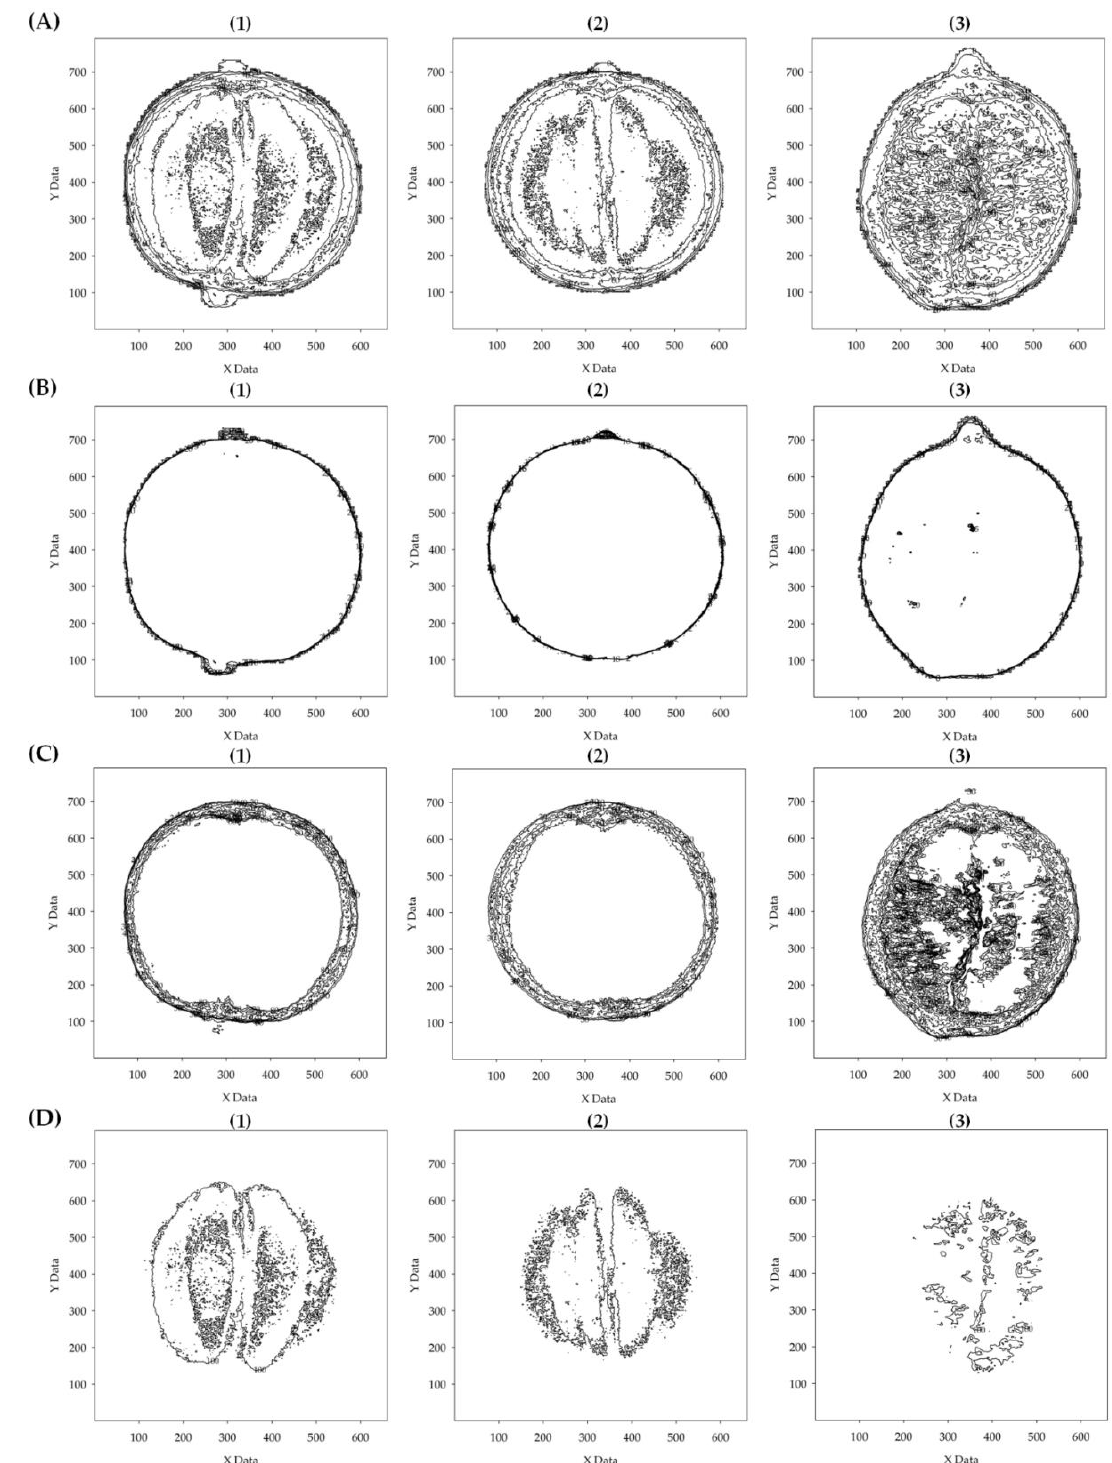
Figure 3. Median-plane images of (1) fresh, (2) mature, and (3) overripe lemons to visualize the results of stratification analyses of the grayscale values, including ( A ) visualization diagrams of the lemon data, ( B ) visualization diagrams of the peel data, ( C ) visualization diagrams of the fiber data, and ( D ) visualization diagrams of the pulp data.